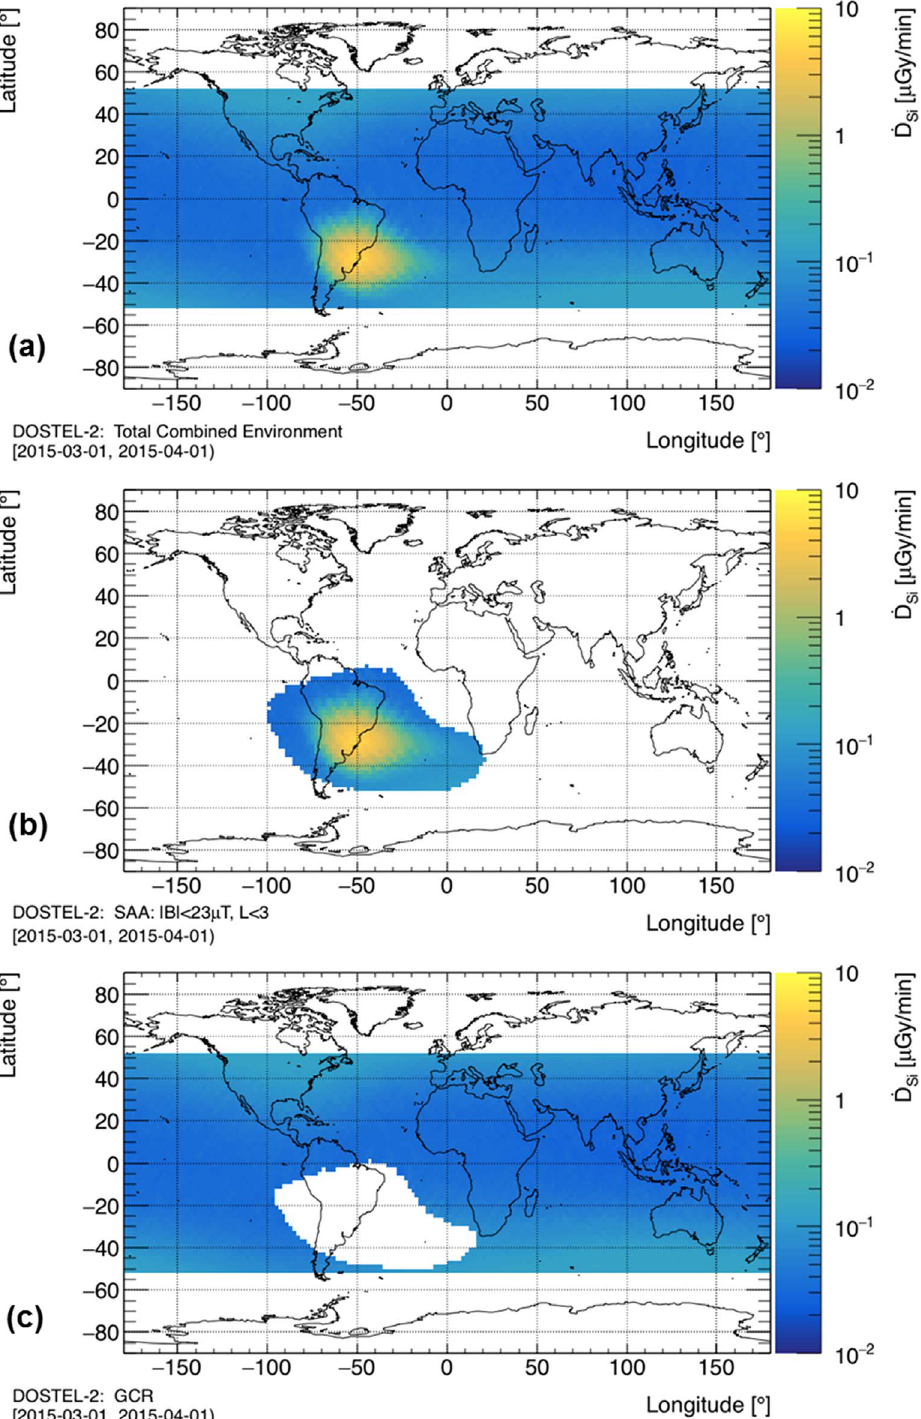
Fig. 5. Example data for the D3D D-2 instrument showing the dose rate over the orbit for March 2015 (a) Full; (b) SAA (see Table 2 column SAA NASA ) cut; and (c) GCR (see Table 2 column GCR NASA